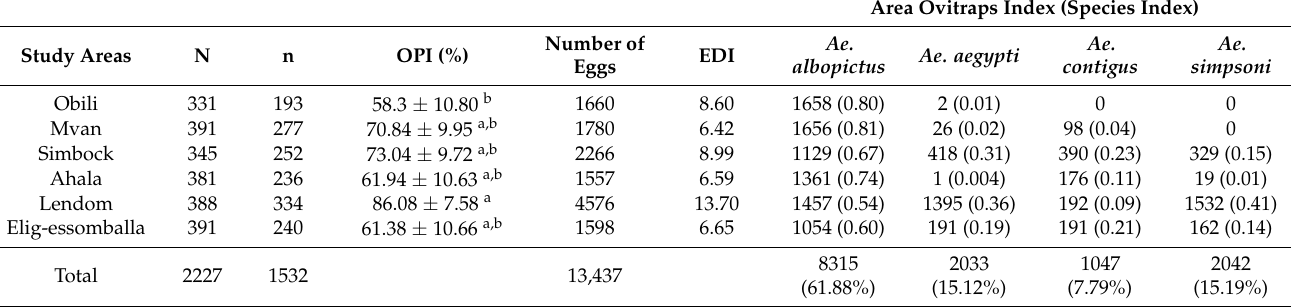
Table 3. Ovitrap indices in each sampling